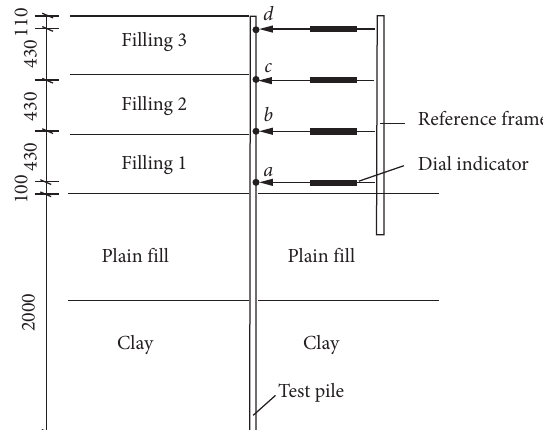
Figure 10: Layout of the displacement